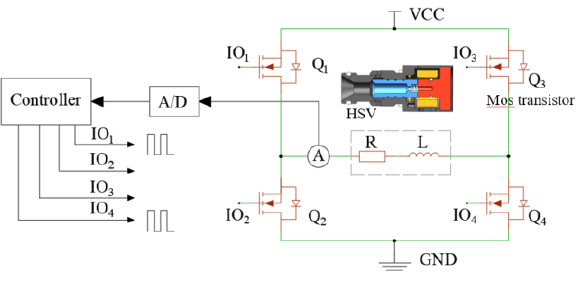
Figure 2. Equivalent circuit of the HSV.